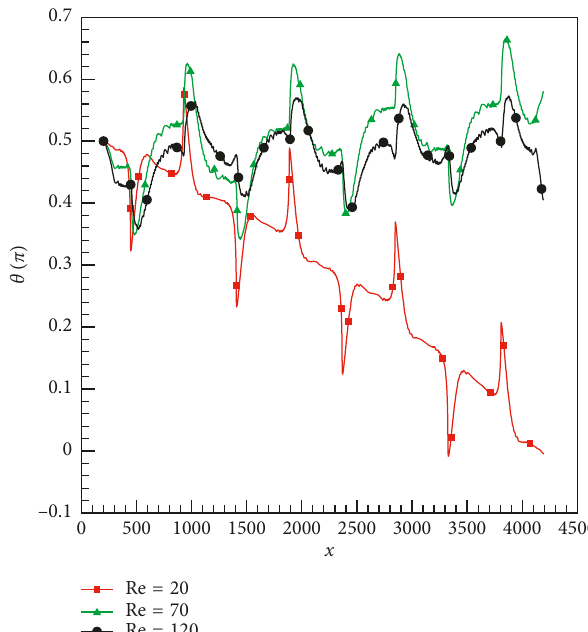
Figure 8: The orientation of the particle for q